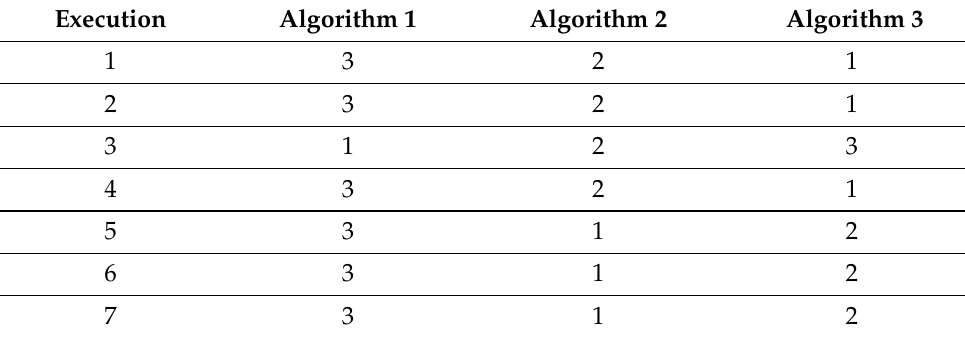
Table 7. Example of ranks for three